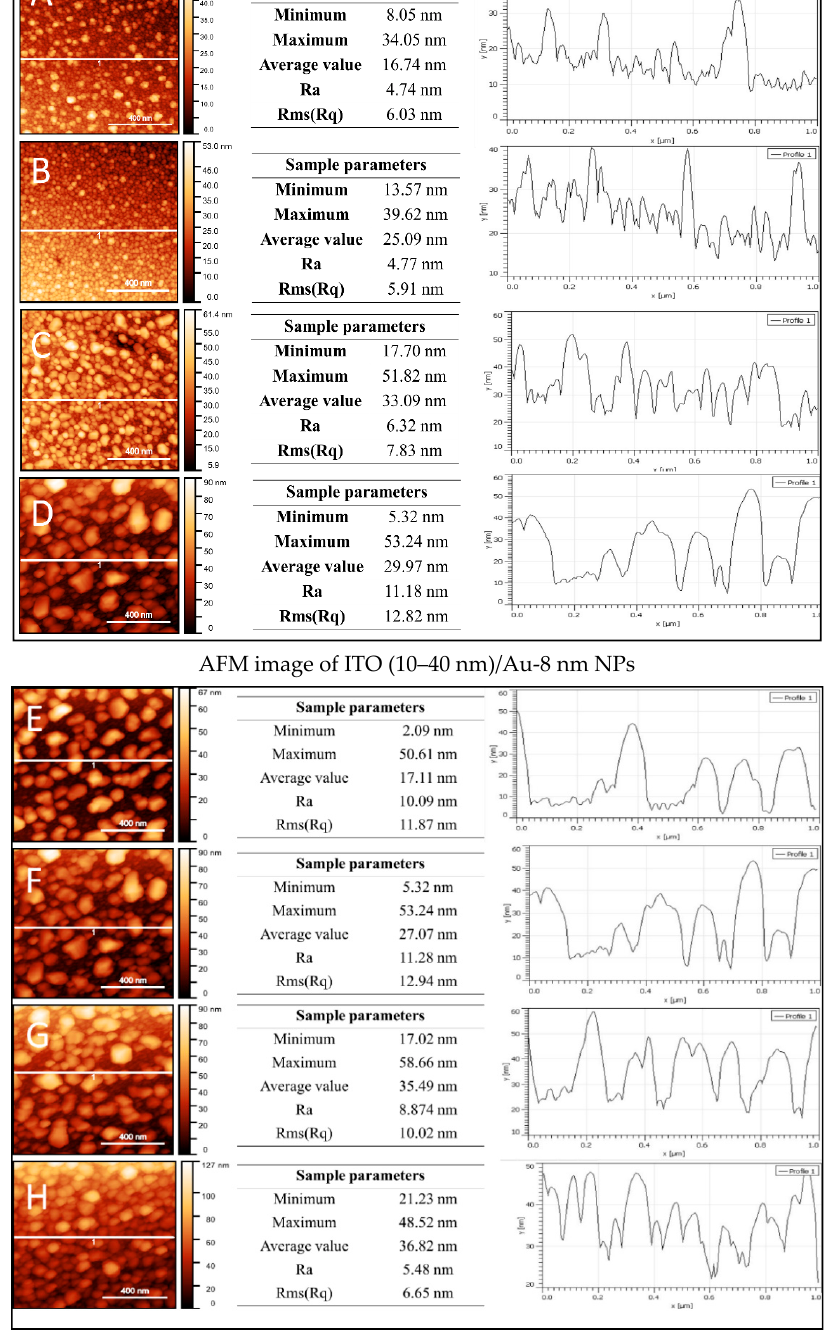
Figure 5. Atomic force microscopy (AFM) images of coverslips coated with (i) different ITO thicknesses ( A ) 10 nm, ( B ) 20 nm, ( C ) 30 nm and ( D ) 40 nm followed by 8 nm Au thickness and (ii): 20 nm ITO further coated with ( E ) Au-2 nm NPs,